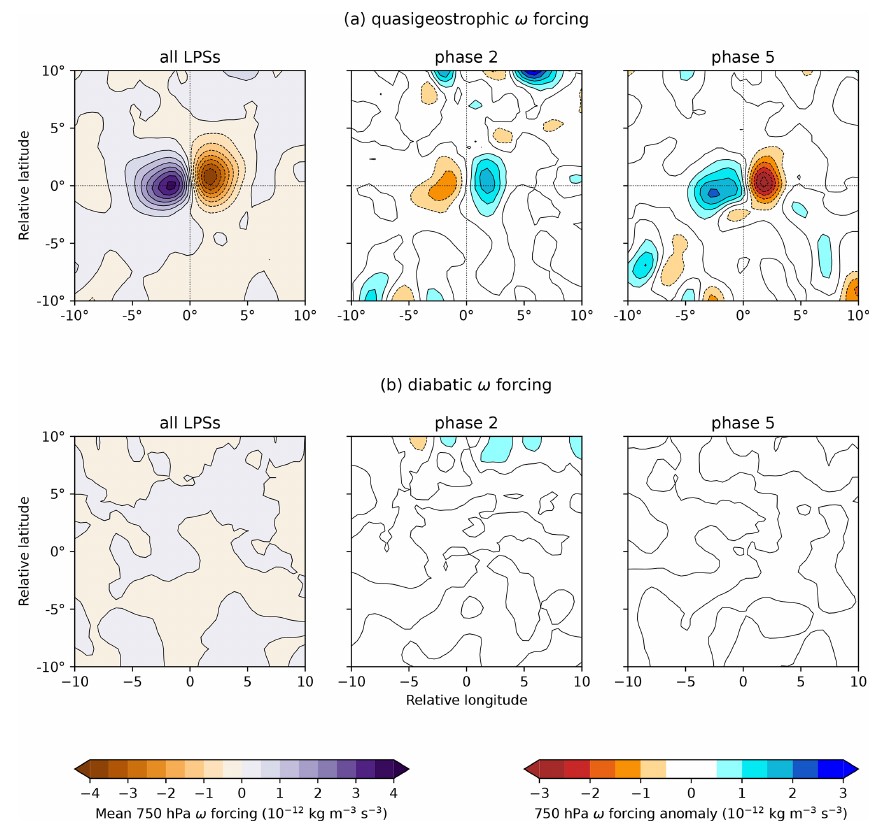
Figure 11. Mean system-centred ω forcing at 750hPa, split into (a) quasi-geostrophic and (b) diabatic contributions. Left: the composite mean for all monsoon LPSs north of 15 ◦ N; centre: the difference between all LPSs and those occurring during BSISO phase 2; right: the difference between all LPSs and those occurring during BSISO phase